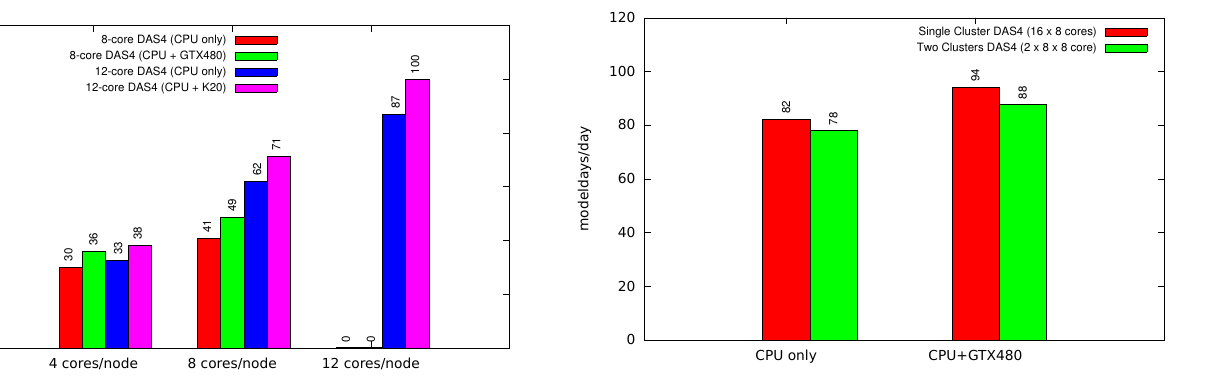
Fig. 11. Performance of POP using 16 compute nodes of the DAS-4 cluster, on one or two clusters, using hierarchical partitioning with 60 × 60 block size.